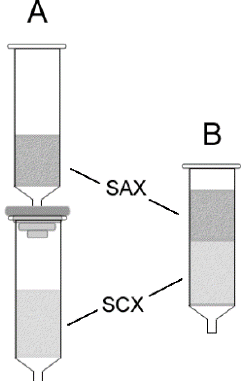
Figure 2. Extraction column configurations in ( A ) dual cartridge format and ( B ) single cartridge format (SAX = strong anion exchange sorbent, SCX = strong cation exchange